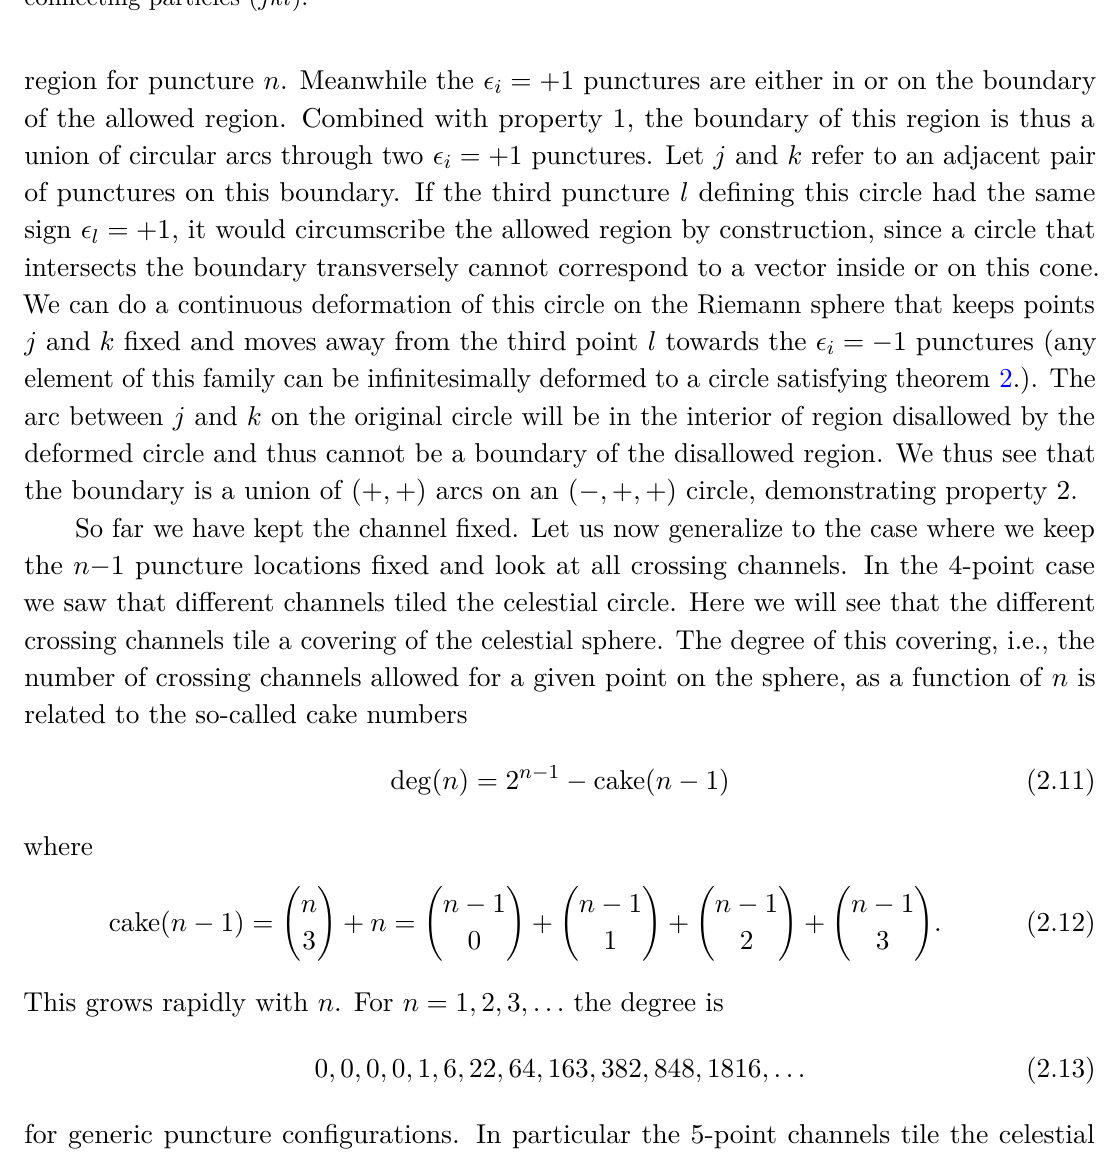
Figure 4 . Sign of Im( r ijkl ) as determined by the position of particle i given the oriented circle connecting particles ( jkl )